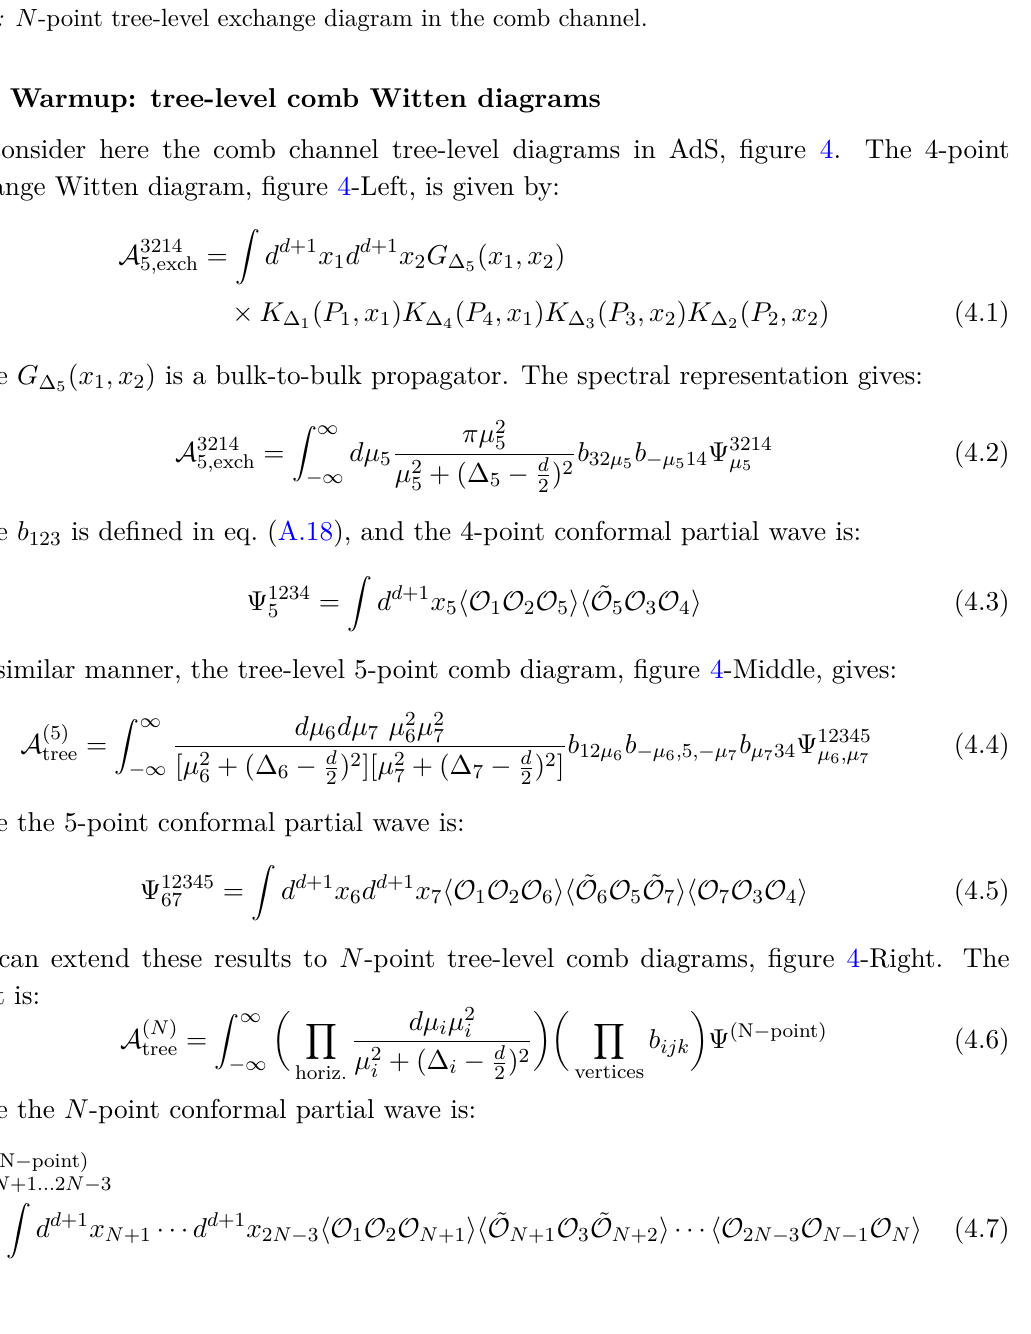
Figure 4 . Left: 4-point tree-level exchange diagram. Middle: 5-point tree-level exchange diagram. Right: N -point tree-level exchange diagram in the comb